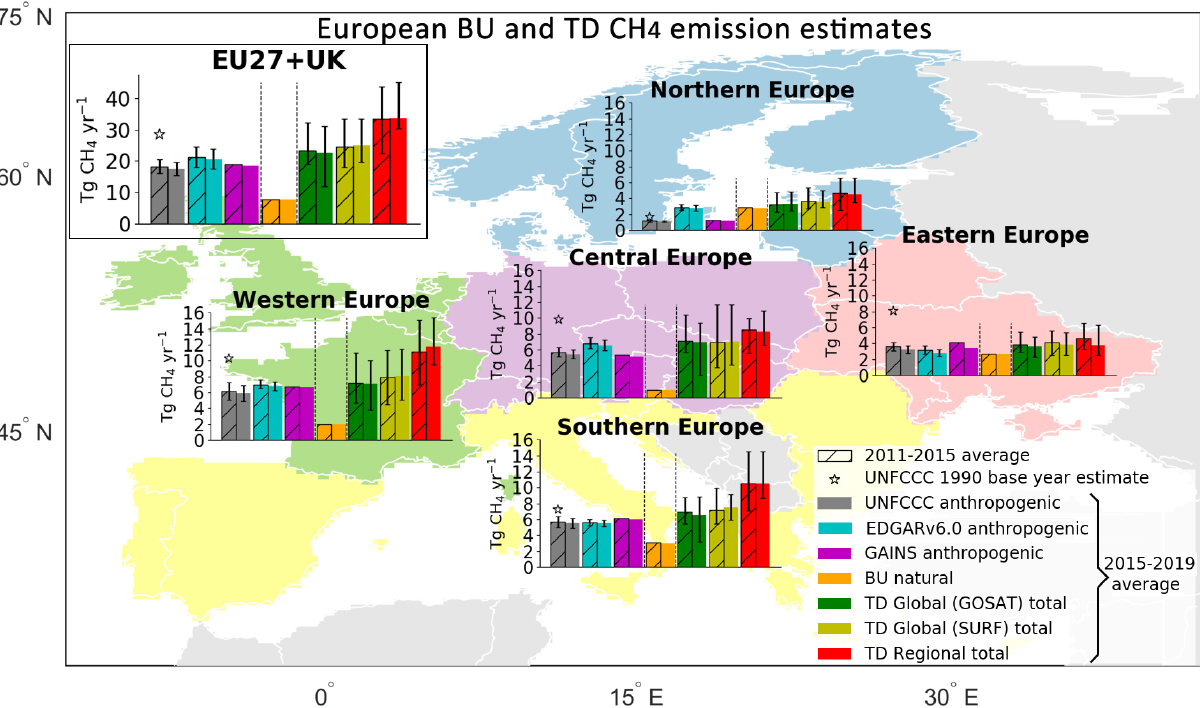
Figure 1. Five-year means (2011–2015, hashed bars, and 2015–2019, full bars) in total CH 4 emission estimates (excluding LULUCF) for the EU27 + UK and five European regions (north, west, central, south and east non-EU). The eastern European region does not include European Russia. Northern Europe includes Norway. Central Europe includes Switzerland. The data come from UNFCCC NGHGI (2021) submissions (gray), which are plotted with respective base year 1990 (black star) estimates, two inventories (GAINS and EDGARv6.0), natural unman- aged emissions (sum of peatland, geological, inland waters (RECCAP2) and GFEDv4.1 biomass burning emissions) and three inversion estimates: one regional European inversion (excluding InGOS unavailable for 2013–2015) and GOSAT and SURF ensemble estimates from global inverse models. The relative error on the UNFCCC value represents the UNFCCC NGHGI (2021) reported uncertainties computed with the error propagation method (95% confidence interval) and gap-filled to provide respective estimates for each year. Uncertainty for EDGARv6.0 was calculated for 2015 based on the 95% confidence interval of a lognormal distribution (Solazzo et al.,